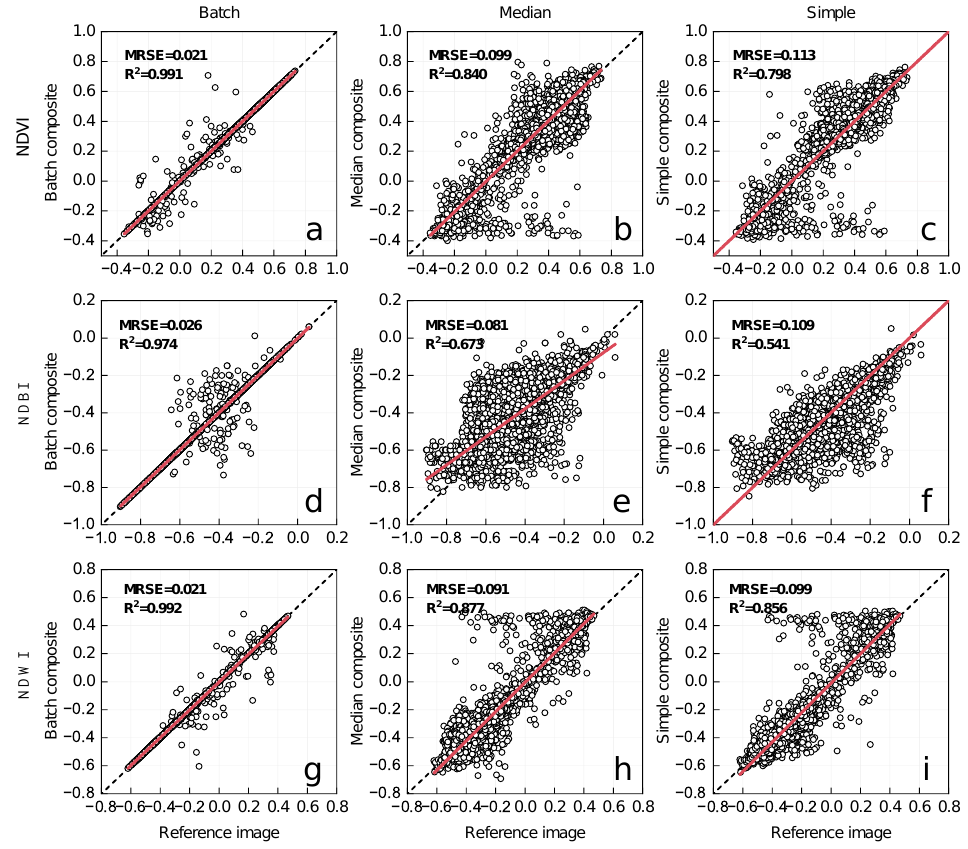
Figure 11. Scatterplot of the differences between NDVI ( a – c ), NDBI ( d – f ), and NDWI ( g – i ) for different